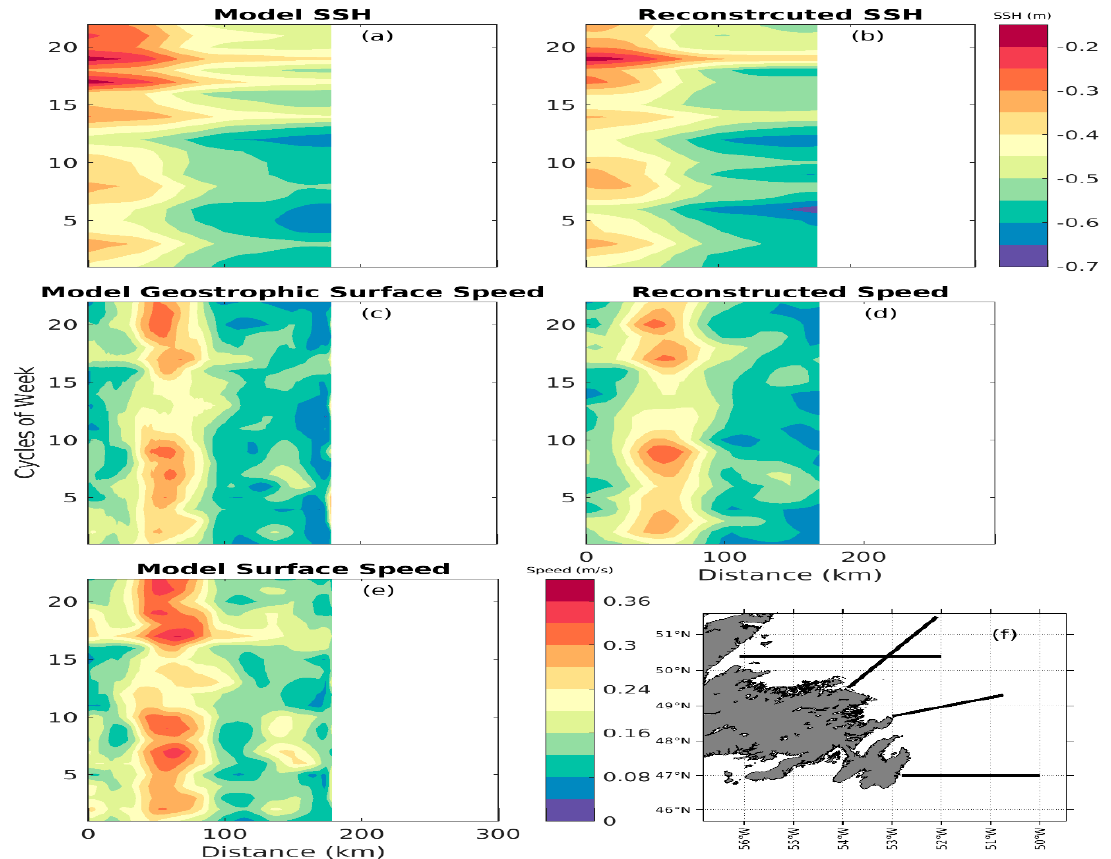
Figure 7. Hovmöller diagram of ( a ) model SSH, ( b ) reconstructed SSH, ( c ) model geostrophic surface current, ( d ) reconstructed surface current, and ( e ) model surface current averaged over four transects within 180 km from the coast. The transects are approximately perpendicular to the mean pathway of the inshore current, with locations indicated by the black lines in ( f ).